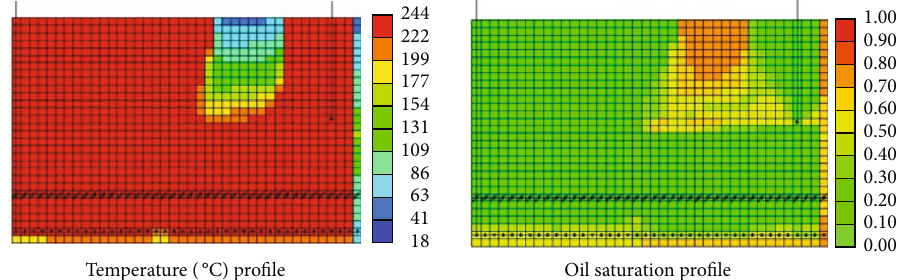
Figure 8: Temperature pro fi le and oil saturation pro fi le of di ff erent schemes for model